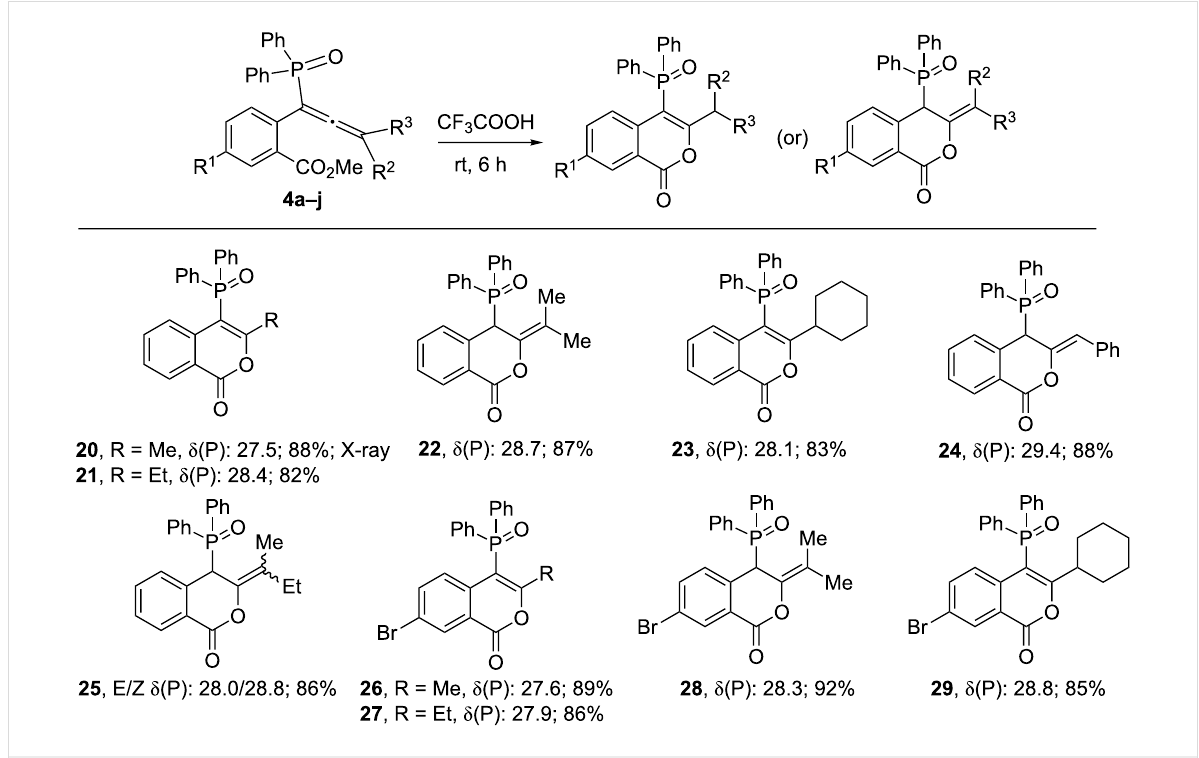
When the above reaction was performed in wet trifluoroacetic acid (TFA/H 2 O = 20:1) at 70 °C, phosphinoylisocoumarins were formed in all cases, but additionally, phosphorus-free isocoumarins 30–35 (Scheme 9) [37] are also formed in the reaction using terminally substituted allenes 4b–d and 4h–j . We have also determined the X-ray structure of compound 33 (Figure 5) for final confirmation. It is possible that isocoumarins 30–35 are formed via the intermediates VIII–IX (Scheme 10) [40]. The phosphorus moiety of IX may then be cleaved as Ph 2 POOH to form the phosphorus-free isocoumarins. Since this was not the interest in the